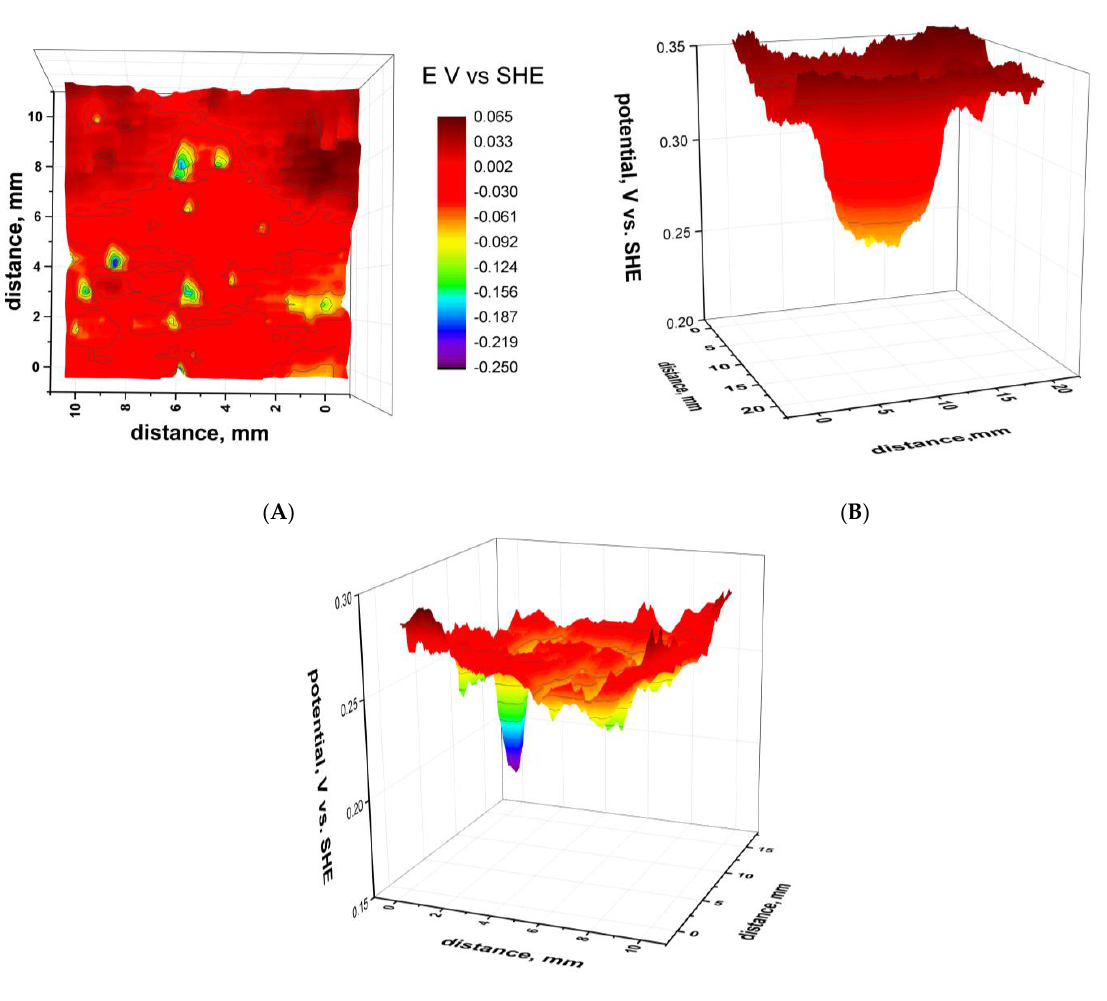
Figure 8. Potential distribution of mild steel SAE 1008, directly polarized ( A ) and permeation ( B ) sides of the membrane. The steel was locally pre-polarized for 1.5 h in 0.1 M NaOH aqueous elec- trolyte using a current density of − 5 mA/cm 2 . SKP measurements were carried out in air at 60%RH 3 h after treatment.